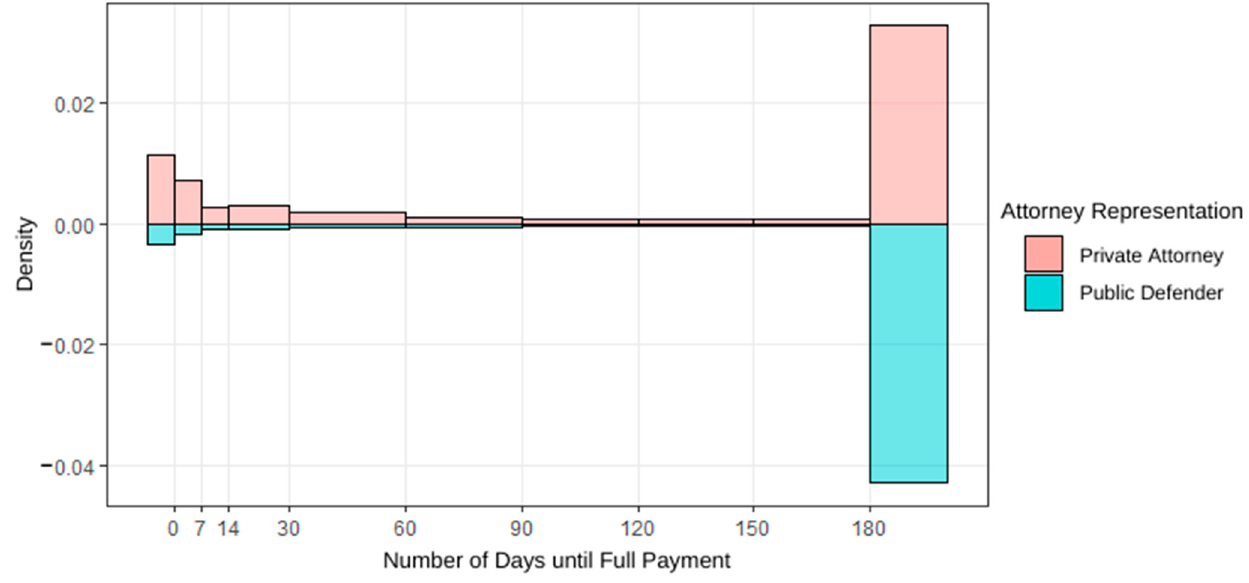
Figure 1. Distribution of the number of days until LFO debt is fully satisfied.